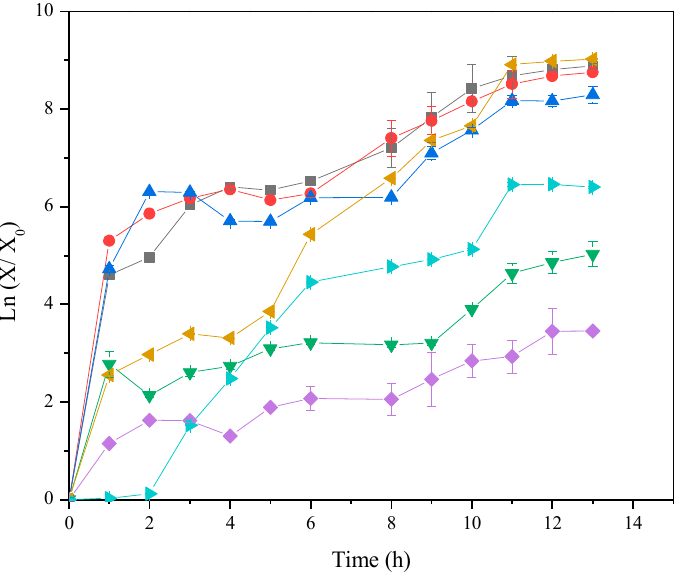
Figure 2. Effect of different carbon sources on cellular growth of B. subtilis ICA 56. Culture medium using: 10 g·L − 1 sucrose ( ■ ), 10 g·L − 1 glucose ( ● ), 10 g·L − 1 fructose ( ▲ ), 5 g·L − 1 glucose + 5 g·L − 1 fructose ( (cid:74) ), 10 g · L − 1 lactose ( (cid:72) ), 10 g · L − 1 glycerol ( (cid:7) ), and 10 g · L − 1 molasses ( (cid:73) ). Culture medium incubated at 37 ◦ C and 150 rpm. Table 3. Growth parameters for Bacillus subtilis ICA 56 and activity of ALDC produced using different carbon sources. Culture medium incubated at 37 ◦ C and 150